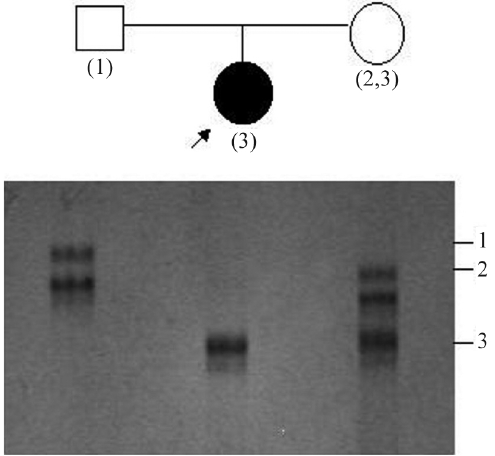
Figure 1 - The androgen receptor ( AR ) gene CAG repeats of a 45,X girl (arrow)andherparentsweregenotypedbyPCRandelectrophoresisusing 6%denaturingpolyacrylamidegel.Thealleleonthegirl’sXchromosome was inherited from her